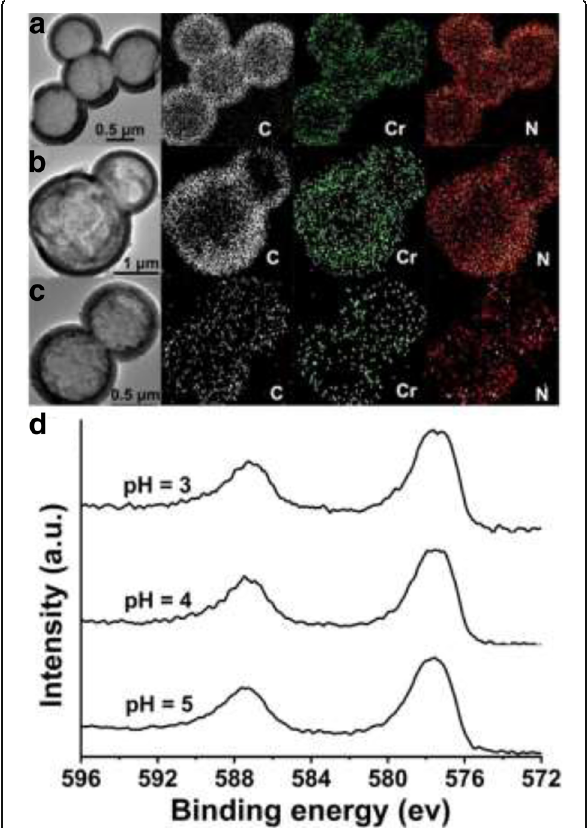
Fig. 5 a – c Element mapping and d Cr 2p XPS spectra of the hollow PANI micro/nanospheres after reaction with Cr (VI) (initial Cr (VI) concentration: 1.2 mmol/L (62.4 mg/L); solution pH respectively at 3, Fig. 6 Nitrogen adsorption-desorption isotherms of the as- synthesized hollow PANI